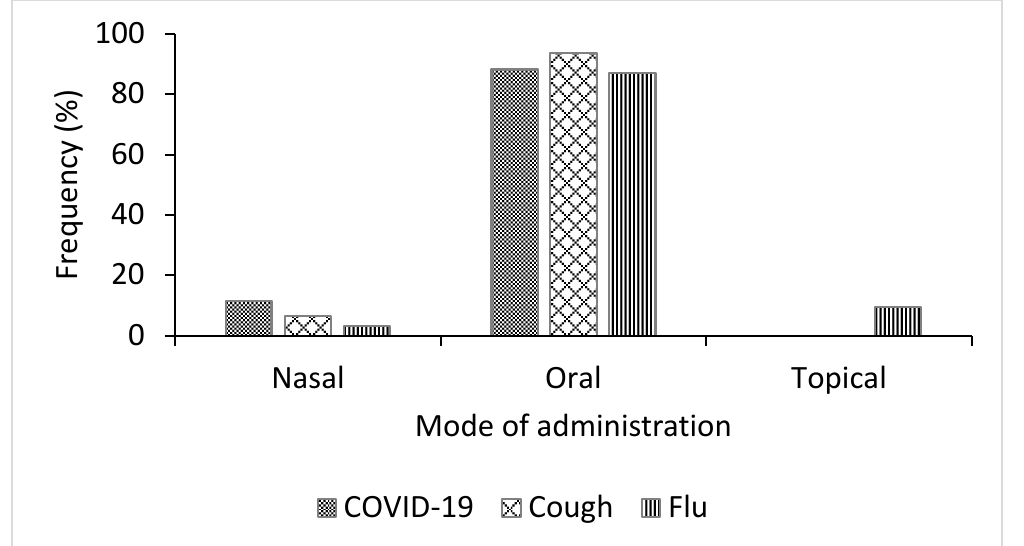
Figure 6. Mode of administration of medicinal plant species used for the treatment of COVID-19, cough, and flu in Ogbomosho North and South Local Government Areas, Oyo State, Nigeria.